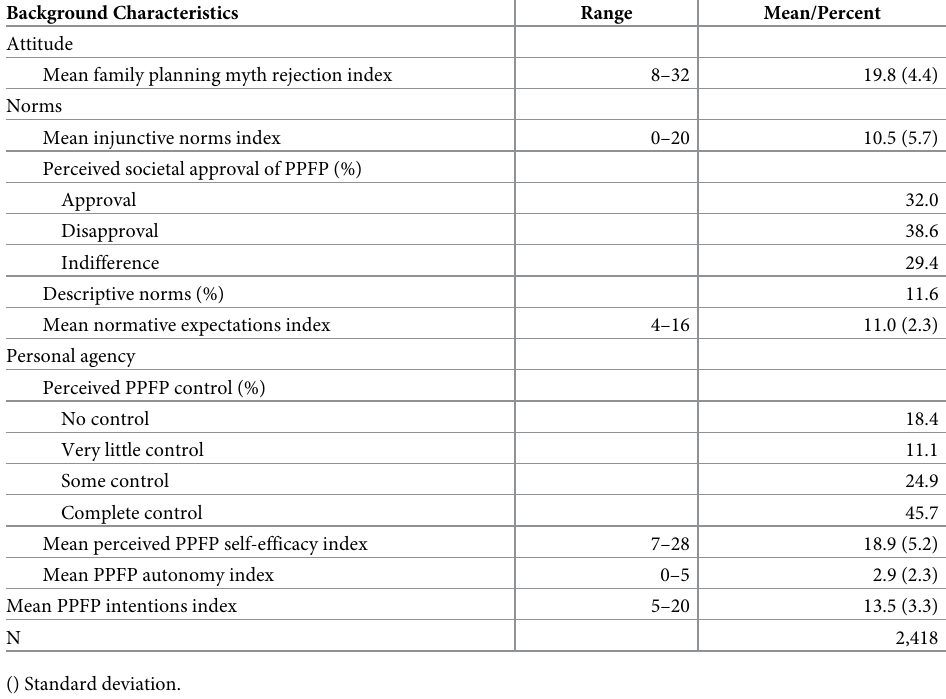
Table 2. Mean indices of postpartum FP-related attitudes, normative beliefs, personal agency and intentions, and percent distribution of FTMs age 15–24 by perceived control over PPFP decisions, Kinshasa